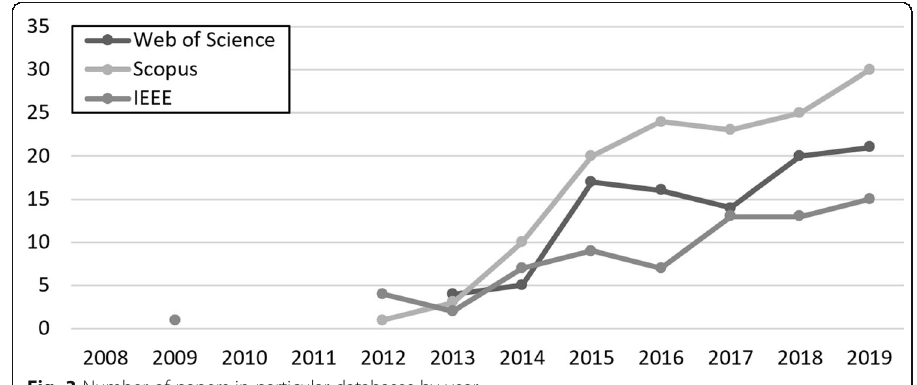
Fig. 3 Number of papers in particular databases by